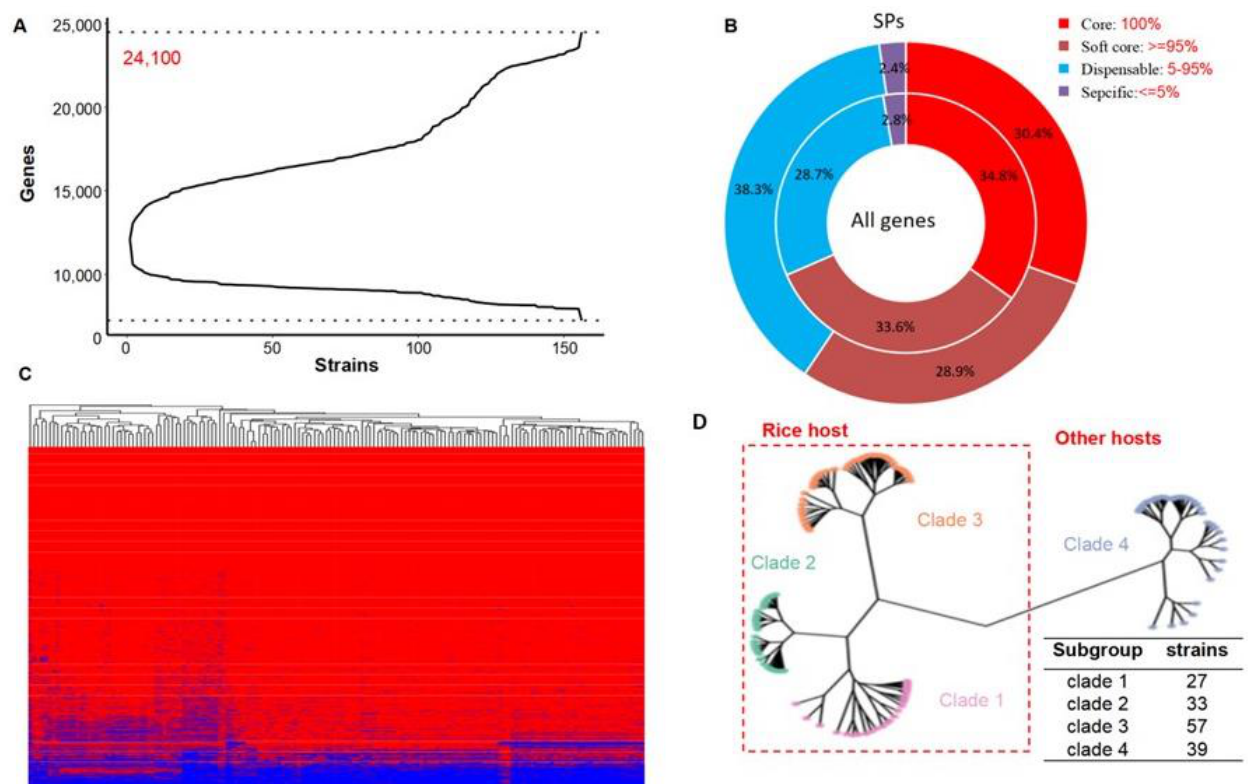
Figure 1. Profile of the pan-genome of P. oryzae . ( A ) The curve of pan-genome. ( B ) Type and percentage of pan-genes. SPs: secreted proteins. ( C ) Gene presence (red)-absence (blue) variation (PAV) analysis. ( D ) Gene PAV-based clustering analysis. It can be divided into four subgroups, including three subgroups from the rice host and one other subgroup from other hosts like wheat.